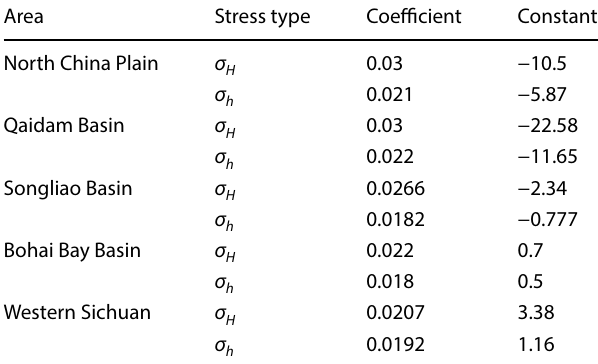
Table 2 Regression coefficients of horizontal principal stresses in other basins in China (Ge Hongkui, 1998)